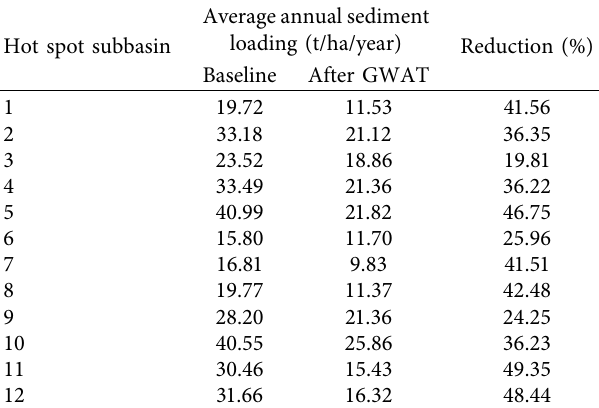
Table 14: Sediment reduction using grassed waterway simulation.